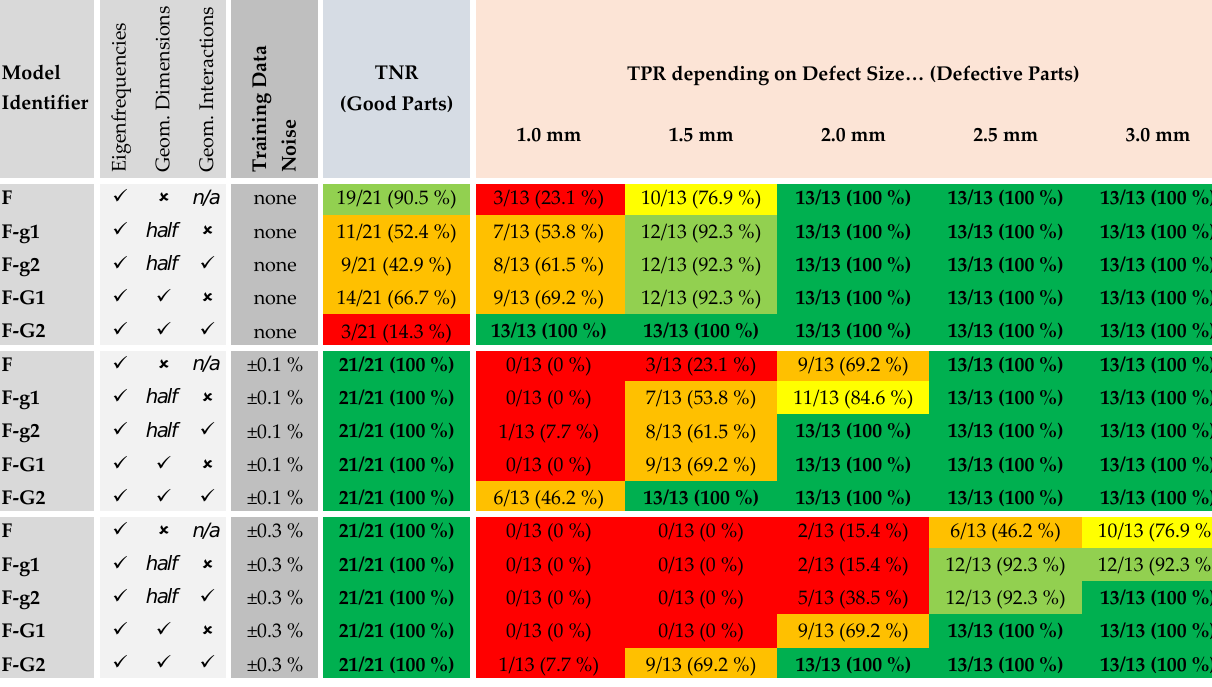
Figure 14. Overview of the classification results for machine-made connecting rods being either undamaged or featuring a defect anywhere in the part with a size between 1 mm and 3 mm, based on various classification models derived from training datasets with different noise